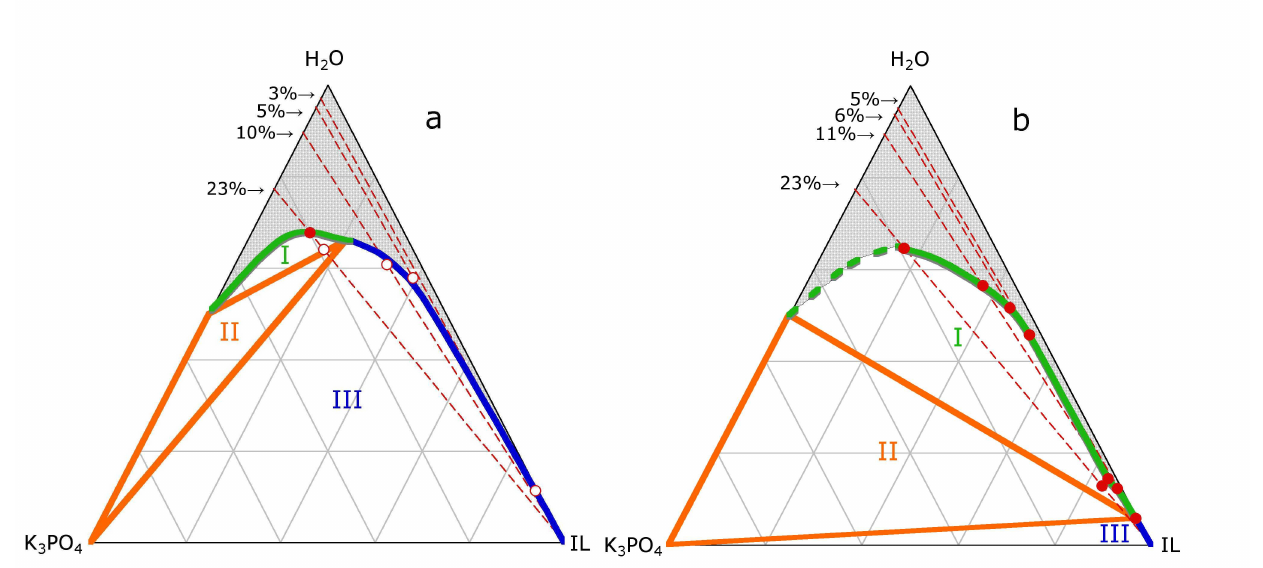
Figure 4. Ternary diagrams of (a) (K [ C mim ][ Et OSO 2